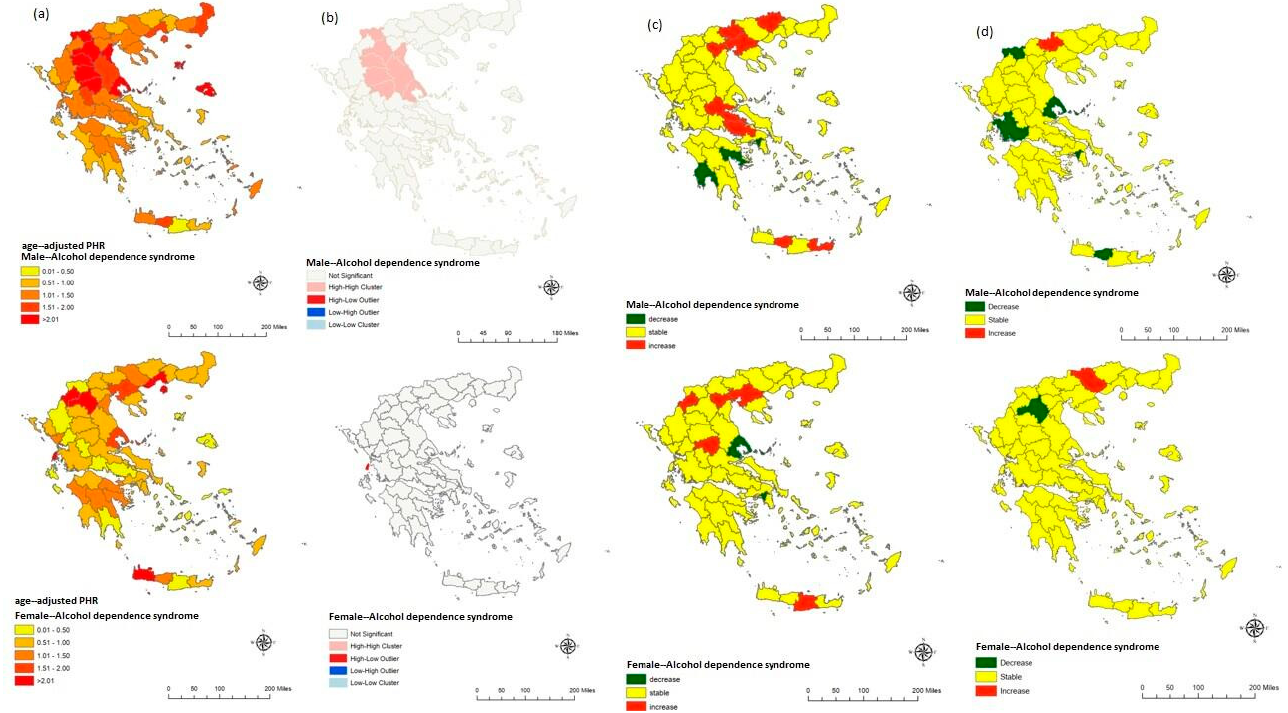
Figure 4 . Descriptive ( a ), LISA ( b ) time series of annual PHR values ( c ) and hospitalization days ( d ) maps per sex for hospitalizations of patients with alcohol dependence syndrome from 1999 to 2012 in Greece.